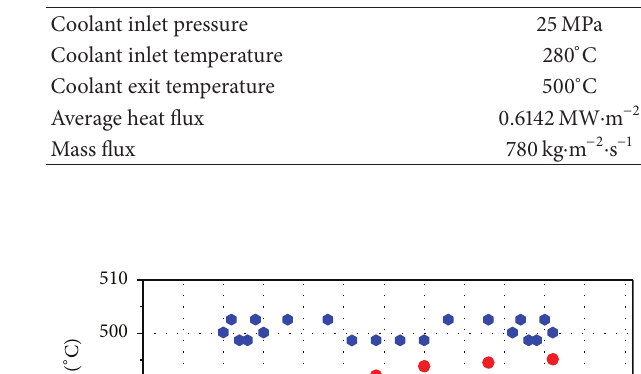
Figure 6: Axial cladding temperature profile in the hot channel.